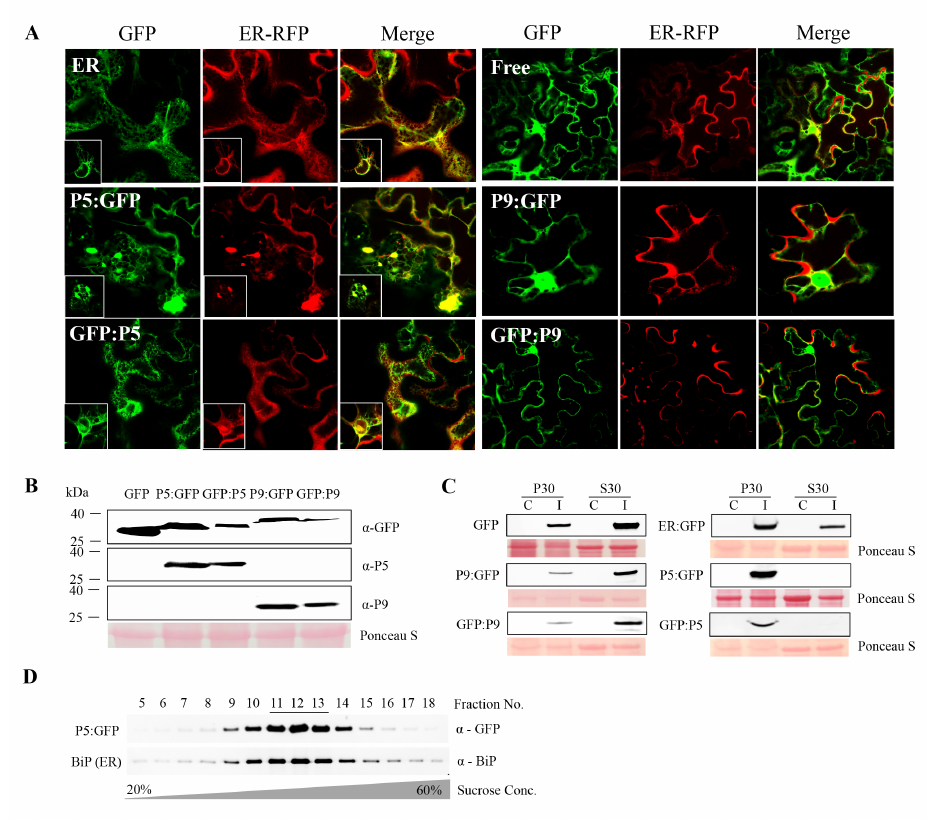
Figure 2. The endoplasmic reticulum (ER) association of LIYV P5. ( A ) Confocal microscopy imaging of leaf epidermal cells of Nicotiana benthamiana plants co-infiltrated with P5- or P9-GFP fusion proteins and ER-localized RFP constructs at two days post-infiltration (dpi) obtained under a 63 × water immersion objective. Free GFP and ER-localized GFP were used as controls. The white square shows the nucleus of the photographed cell. ( B ) Fusion protein expression detected by immunoblotting using GFP, LIYV P5 and P9 specific antibodies. Free GFP was used as a control. ( C ) Cellular fractionation of P5 and P9 GFP fusion proteins. The 30,000 × g pellet (P30) and supernatant (S30) fractions were analyzed by immunoblots using anti-GFP antibody. Free GFP and ER-localized GFP were examined as controls. The Ponceau S stained rubisco large subunit serves as a loading control. ( D ) Immunoblot analysis of the P30 fraction of P5:GFP fusion protein following separation in 20% to 60% sucrose gradients. Fractions from top to bottom (5 to 18) were analyzed by immunoblots using anti-GFP and anti-BiP antibodies to detect P5:GFP and BiP (ER-resident marker